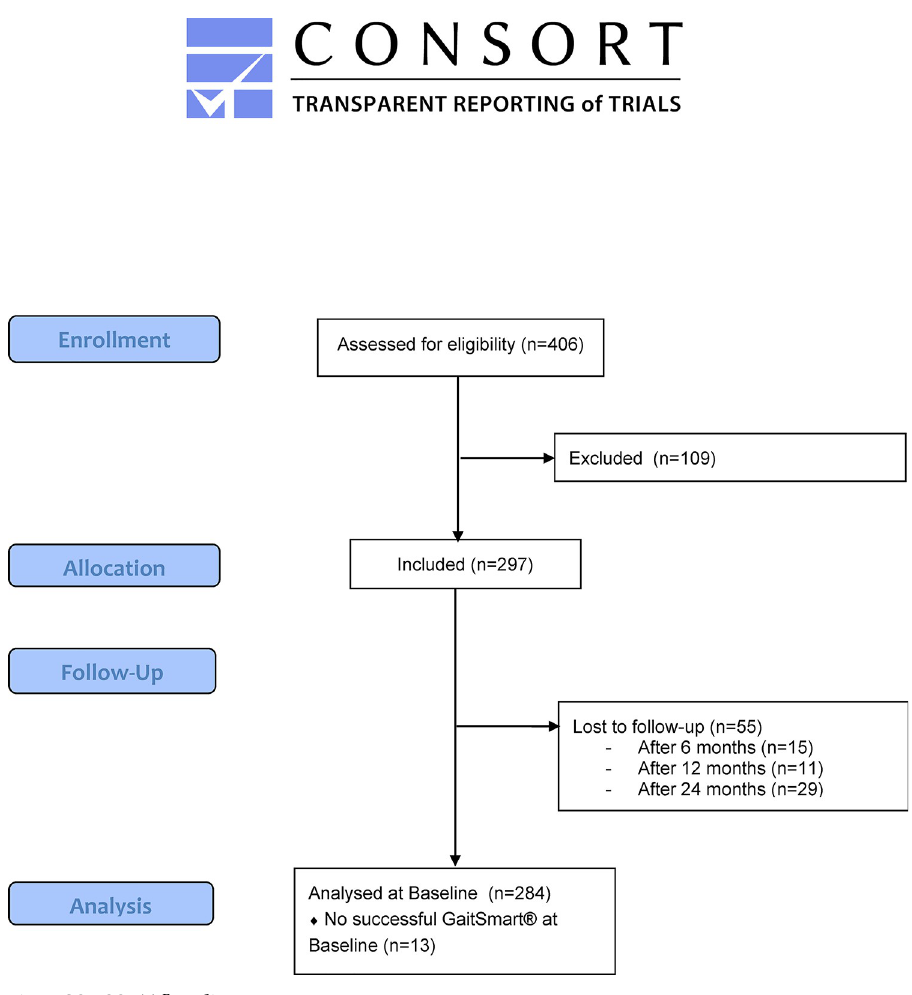
Fig 1. CONSORT flow diagram.